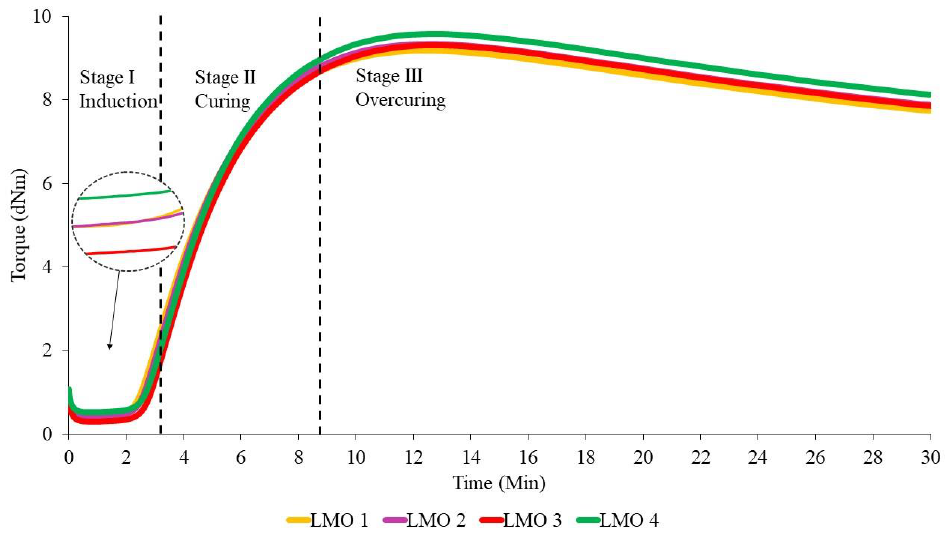
Figure 2. The curing curves of NR-based MREs for different ratios of LMO:AO.